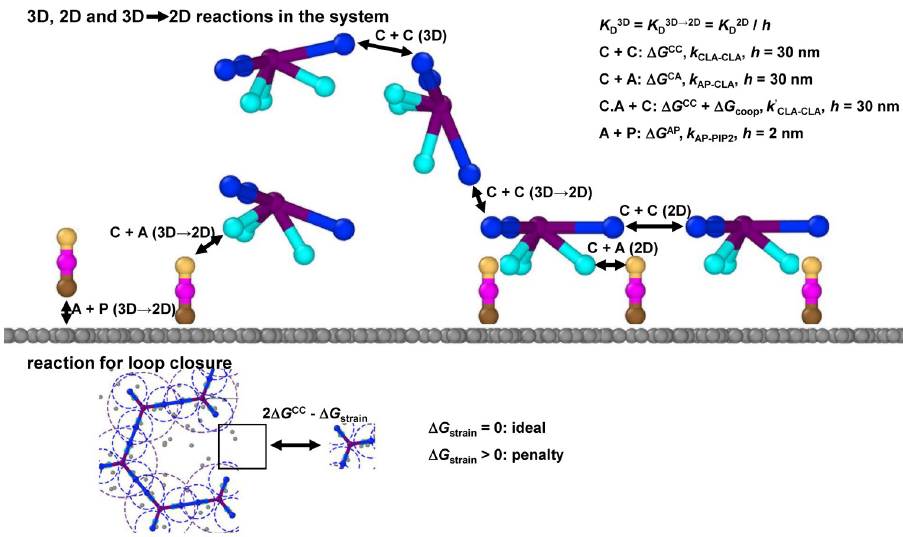
Fig 2. Reaction network for the model captures energetics and kinetics of binding in 3D, 2D, and between 3D-2D. For components clathrin (labeled C), adaptor (A), and lipid (P), only the specific reactions shown in black arrows occur between the connected interfaces. The legend indicates what parameters per reaction are specified, where a 2D reaction relates to the corresponding 3D reaction via a lengthscale h due to the change in dimensionality of the search. When a clathrin-adaptor complex forms (C.A), it binds other clathrin more strongly via Δ G coop . The lower panel shows how the addition of a monomer can close a hexagonal loop. The free energy of forming both bonds is modeled with negative cooperativity, via an energy penalty Δ G strain